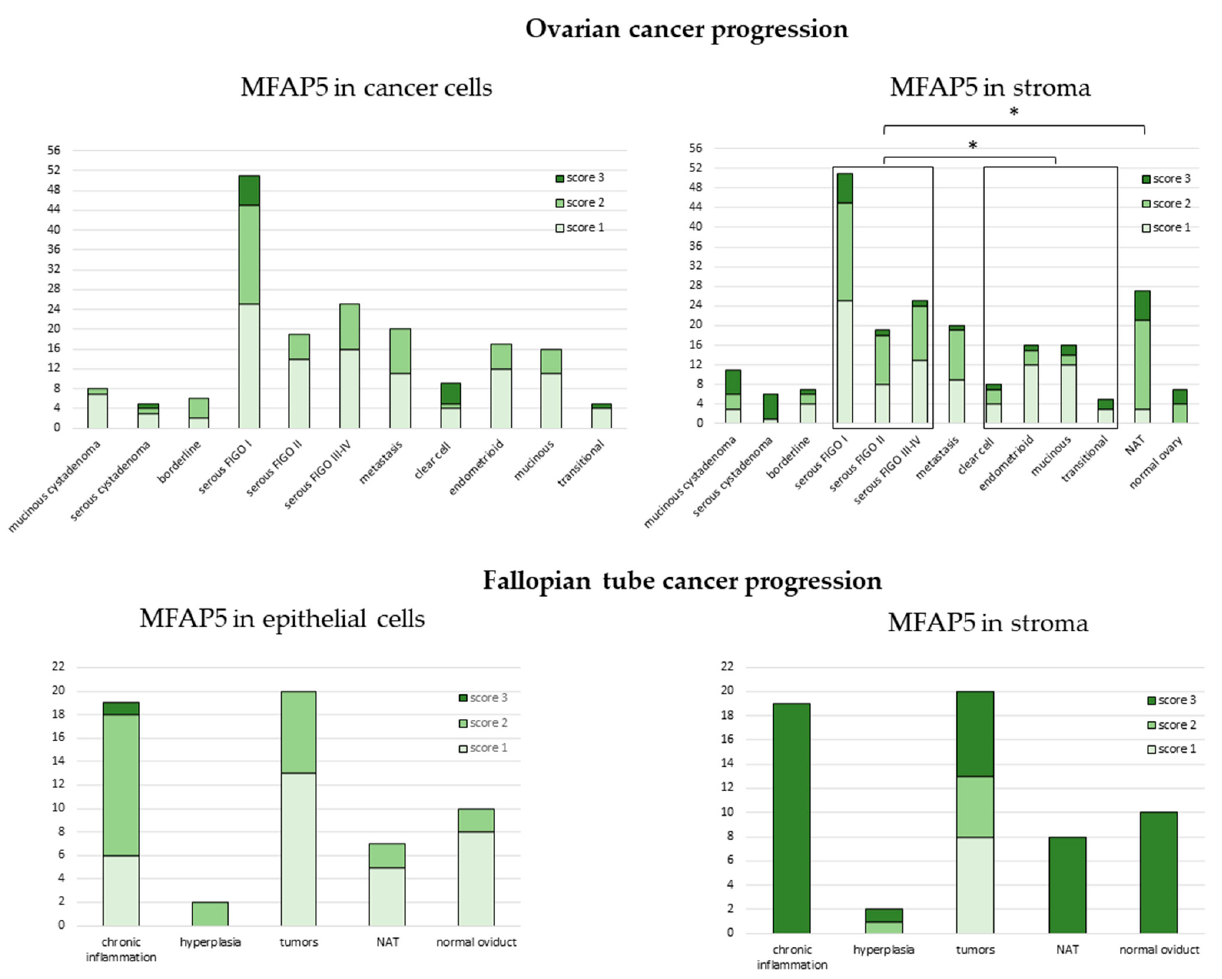
Figure 5. Expression of MFAP5 in tissue arrays. The y axis represents number of samples. NAT—normal tissue adjacent to the tumor. * − denotes p < 0.05.